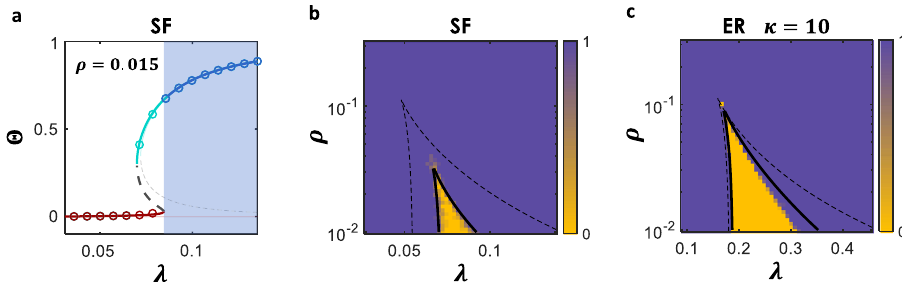
Fig. 4 Large fl uctuations. Results for scale-free (SF) networks and Erd ő s-Rényi (ER) with low degrees which have large fl uctuations, and thus demand analysis using Eq. (5) rather than Eq. (8). a The order parameter Θ , Eq. (3), for a forced system with ρ = 0.015 and Δ = 5. The network here is scale-free with N = 10 4 , minimal degree k 0 = 15, and exponent γ = 3.5. The symbols are from simulations and the line is from theory, Eq. (5). b For the same network as in ( a ), the ( λ , ρ ) phase diagram shows a signi fi cantly narrower unsustainable regime compared to ER. The black continuous lines are from Eq. (5), while the dashed lines are from Eq. (8), which captures well ER networks but fails to predict SF. c Results for ER network with κ = 10, which is a smaller degree than in Fig. 3g. Also, here, the theory of Eq. (5) (full line) is better than Eq. (8) (dashed